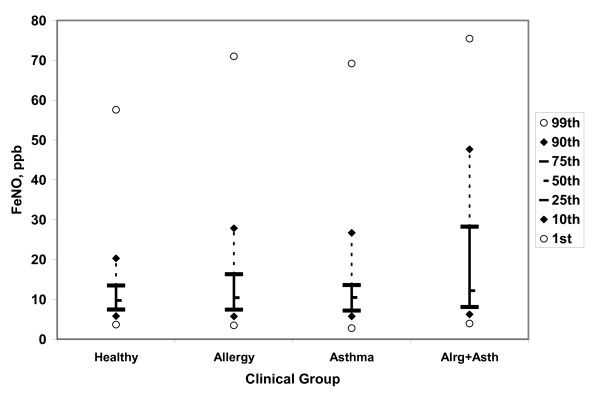
Percentile distributions of estimated online FeNO for healthy, allergy-only, asthma-only, and allergy-plus-asthma subjects. See Table 1 for number of subjects in each group. Allergy-only and allergy-plus-asthma groups are significantly (P < 0.0001) different from healthy group; asthma-only group is not significantly different.